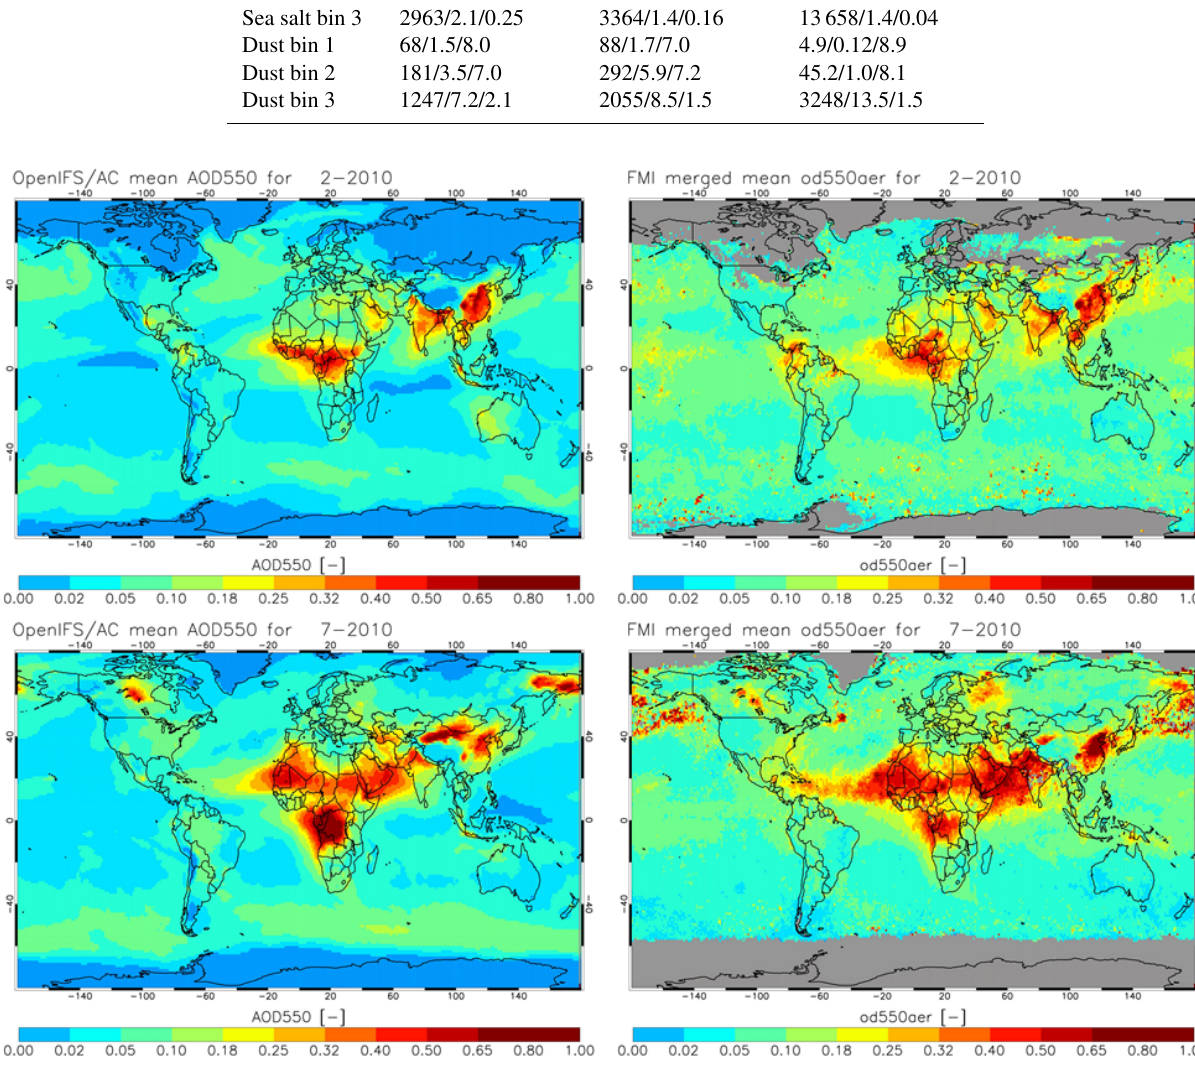
Figure 8. Intercomparison of total AOD at 550nm for February and July 2010, for OpenIFS/AC-CB05-AER and the Finnish Meteorological Institute (FMI) merged AOD